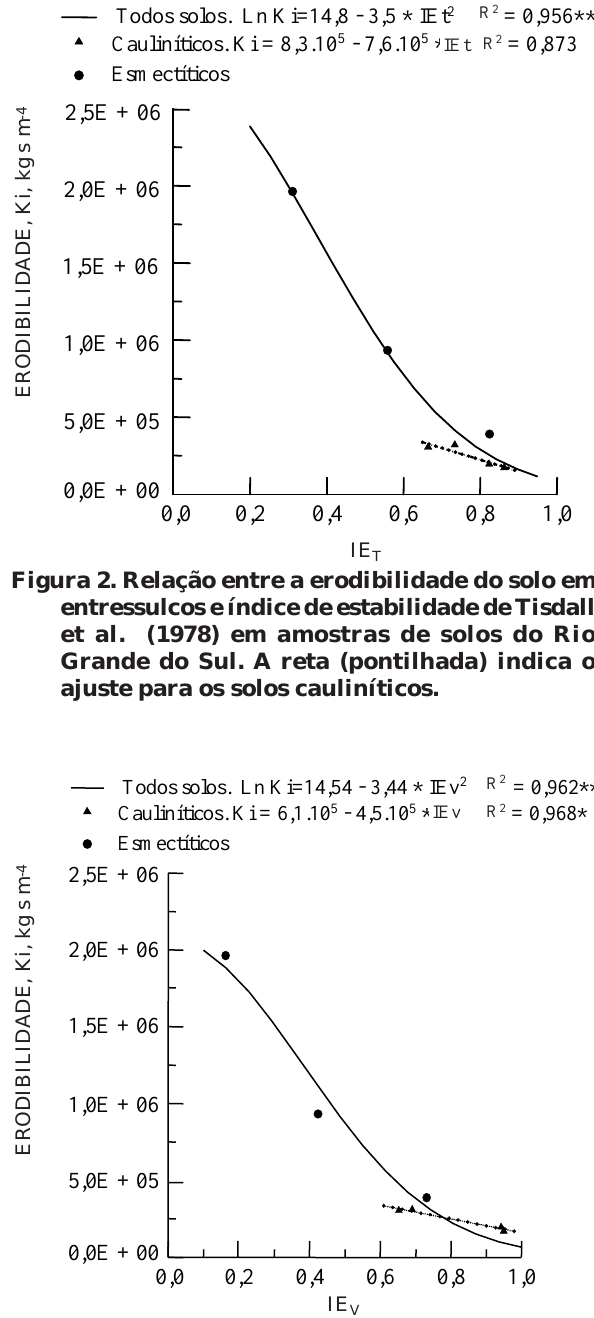
Figura 3. Relação entre a erodibilidade em entressulcos e índice de estabilidade de Veiga et al. (1993) (IE ), em amostras de solos do Rio V Grande do Sul. A reta (pontilhada) indica o ajuste para os solos